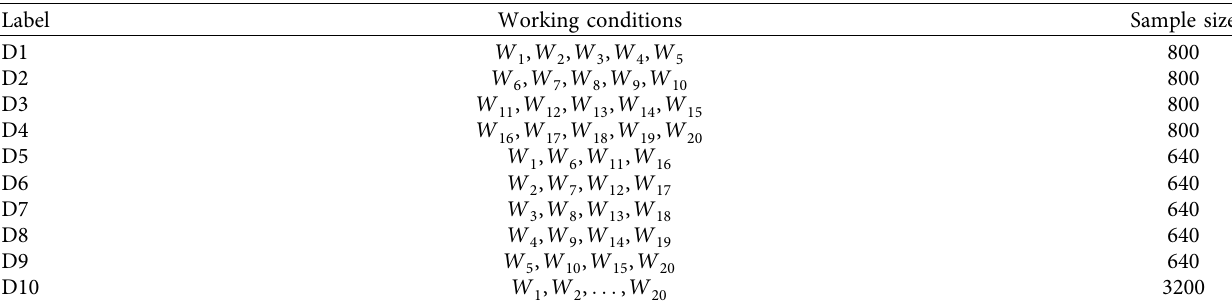
Table 8: Details of 10 datasets used for experimental